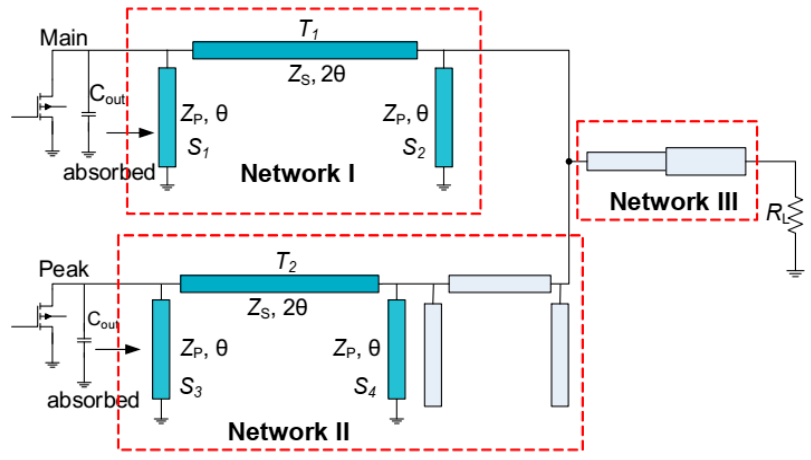
Figure 8. Schematic dual-band circuit proposed by [18].